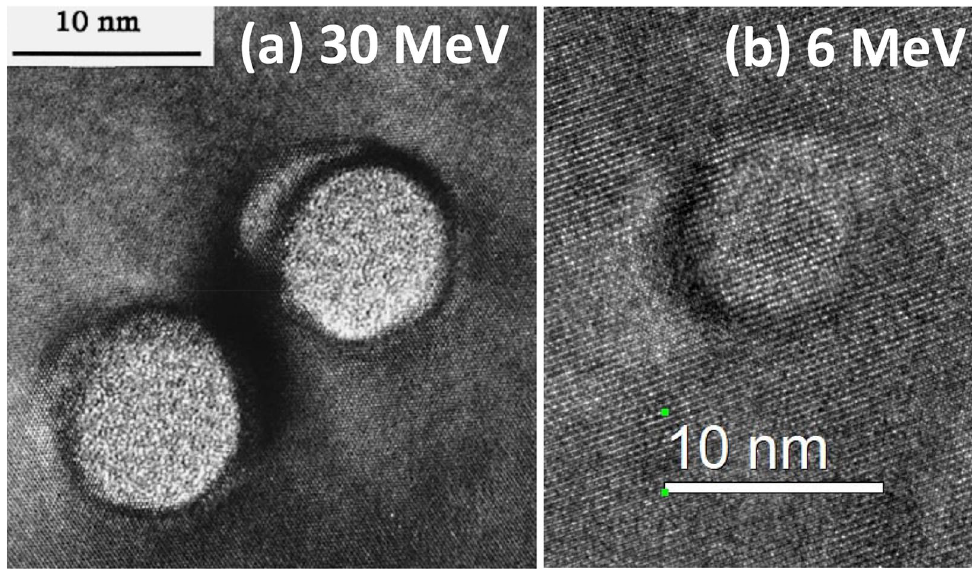
Figure 5. High resolution TEM images of ion tracks in c-Si irradiated with C 60 + ions of ( a ) 30 MeV ( reproduced with permission from A. Dunlop et al. Ref. 8 ) and of ( b ) 6 MeV (this